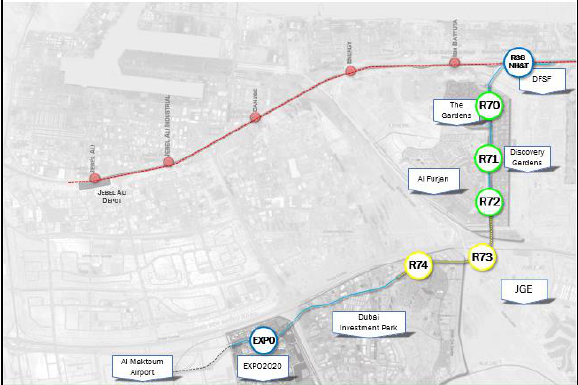
Figure 5 . Preferred alignment No. 4 (Roads &